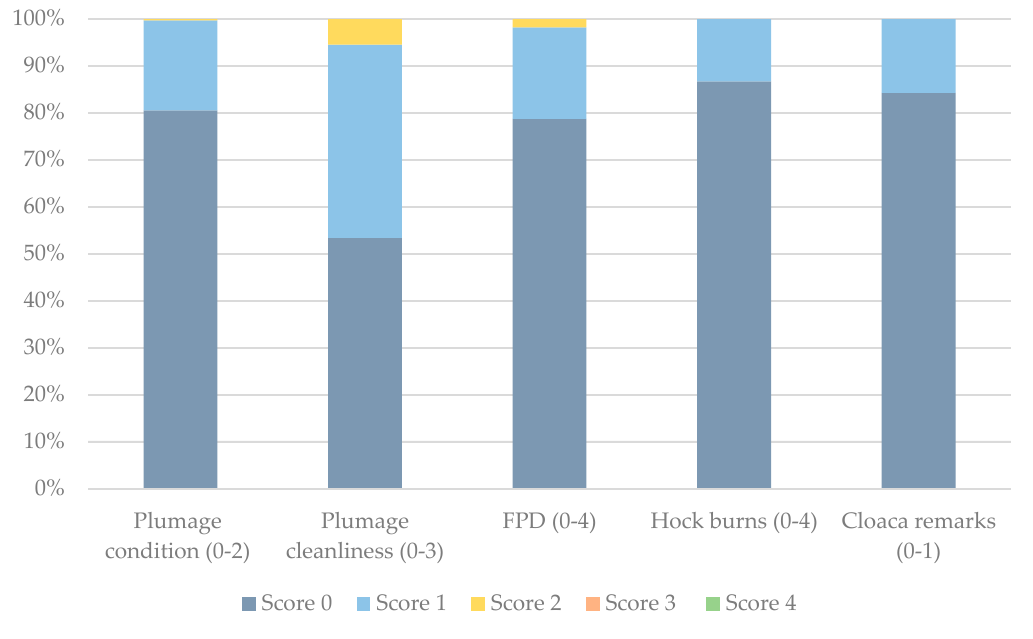
Figure 4. Proportion (%) of chickens ( n = 400) with di ff erent plumage condition, plumage cleanliness, foot pad dermatitis (FPD) and hock burn scores and cloaca remarks (0 = no remarks, 1 = signs of enteritis / diarrhoea) (Welfare Quality ® ) in flocks ( n = 8) observed on Swedish organic broiler